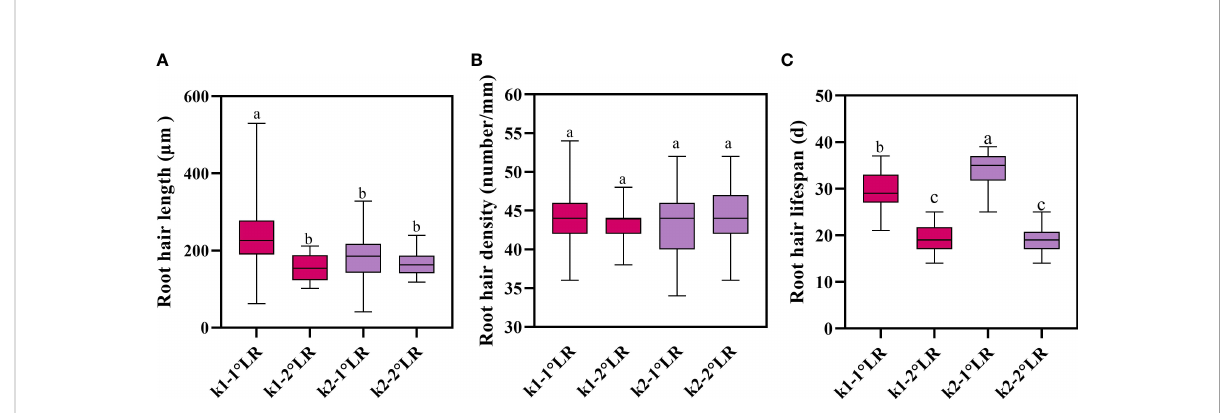
FIGURE 9 Root hair traits of cotton. (A) Average root hair length, (B) average root hair density, and (C) average root hair lifespan. K1-1°LR, the primary lateral roots of K836; K1-2°LR, the secondary lateral roots of K836; K2-1°LR, the primary lateral roots of K837, K2-2°LR, the secondary lateral roots of K837. Different letters indicate signi fi cant differences between treatments